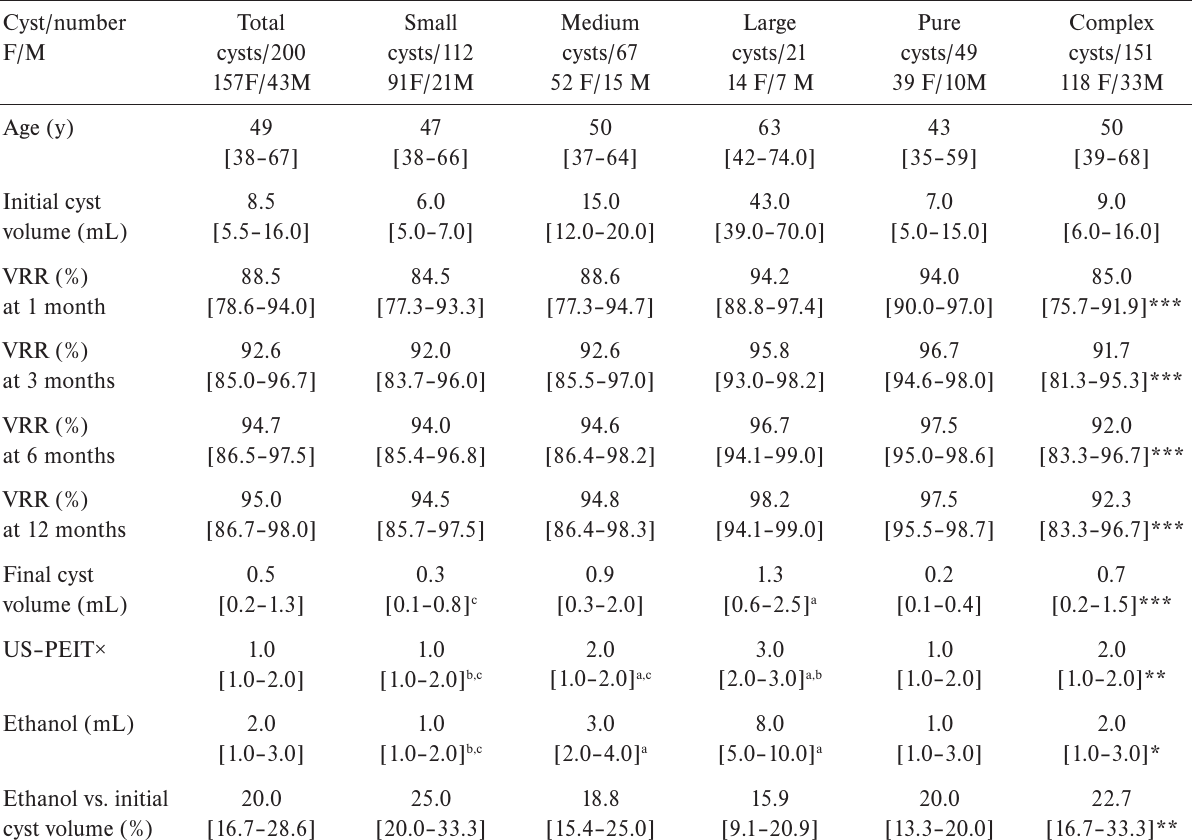
Table 1. US–PEIT of thyroid cysts study: results for the entire cohort, three subgroups by cyst volume and two subgroups by character of the cystic